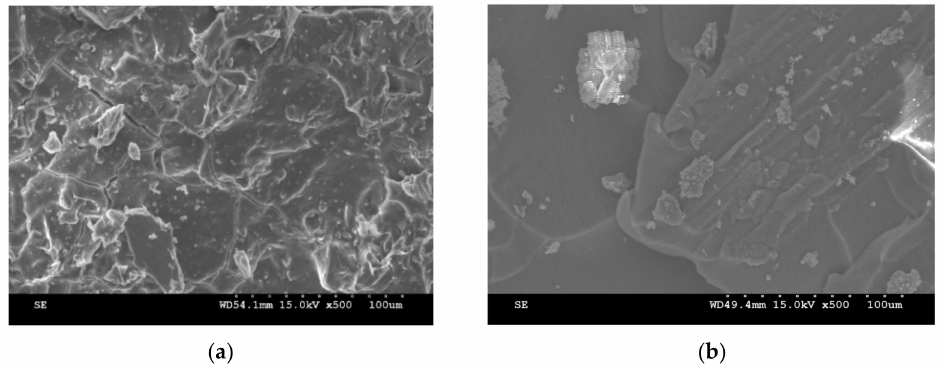
Figure 9. SEM imaging at a magnification of 15 k for ( a ) the SiR + 30 wt% GS10 and ( b ) SiR + 5 wt% FS07 composites tested using the +DC IPT.